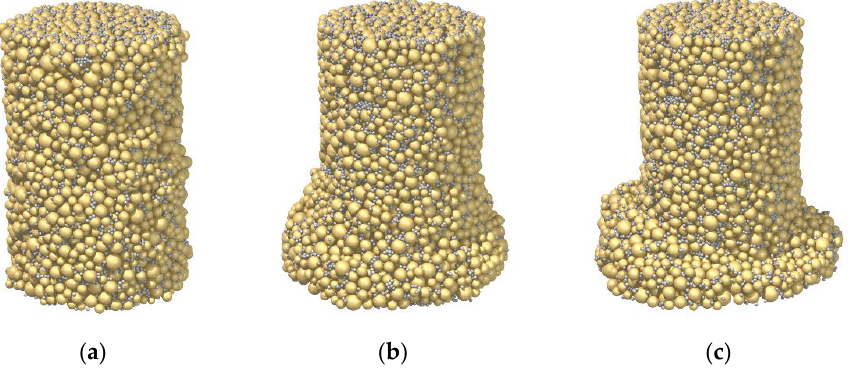
Figure 4. Influence of the curing time on the failure mode: ( a ) Sample C3_R5L; ( b ) Sample C7_R5L; ( c ) Sample